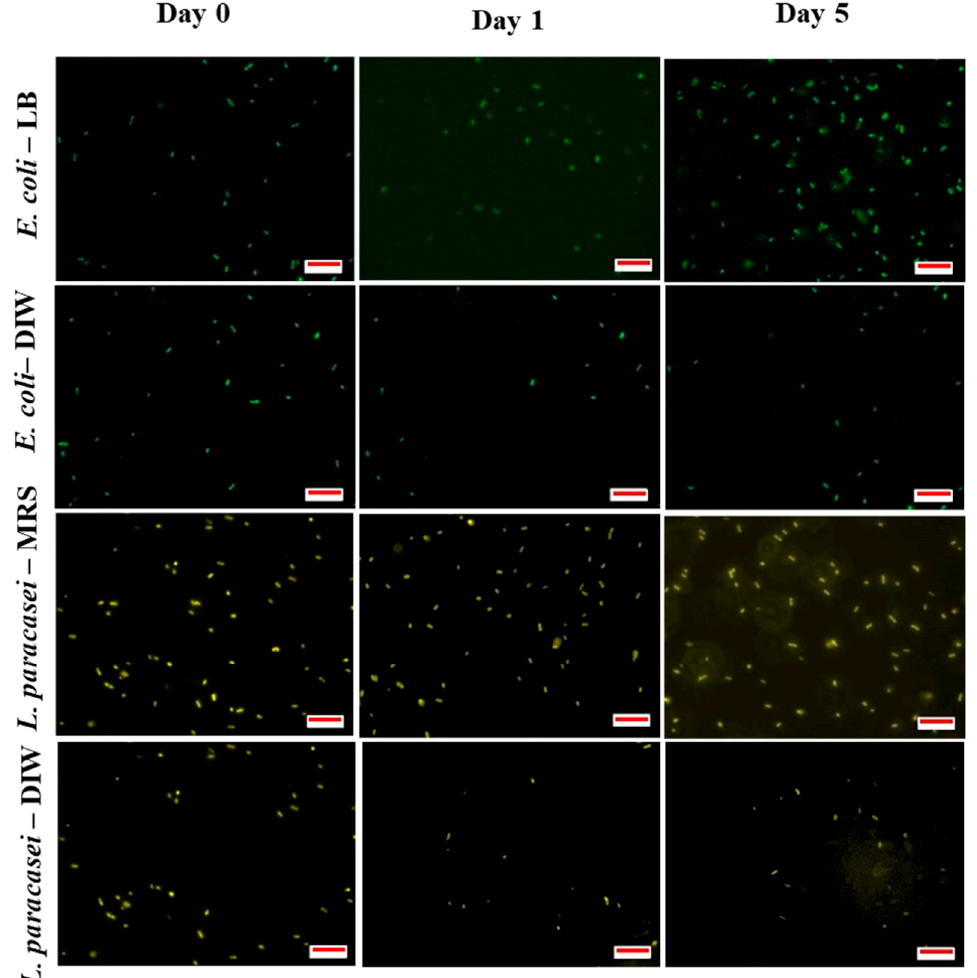
Figure 5. Photomicrographs of free (unencapsulated) bacterial cells suspended in LB broth (for E. coli , shown by green coloured cells) and MRS broth (for L. paracasei, shown by yellow coloured cells). No bacterial clusters were observed during five days of storage. Scale bar: 10 μ m.